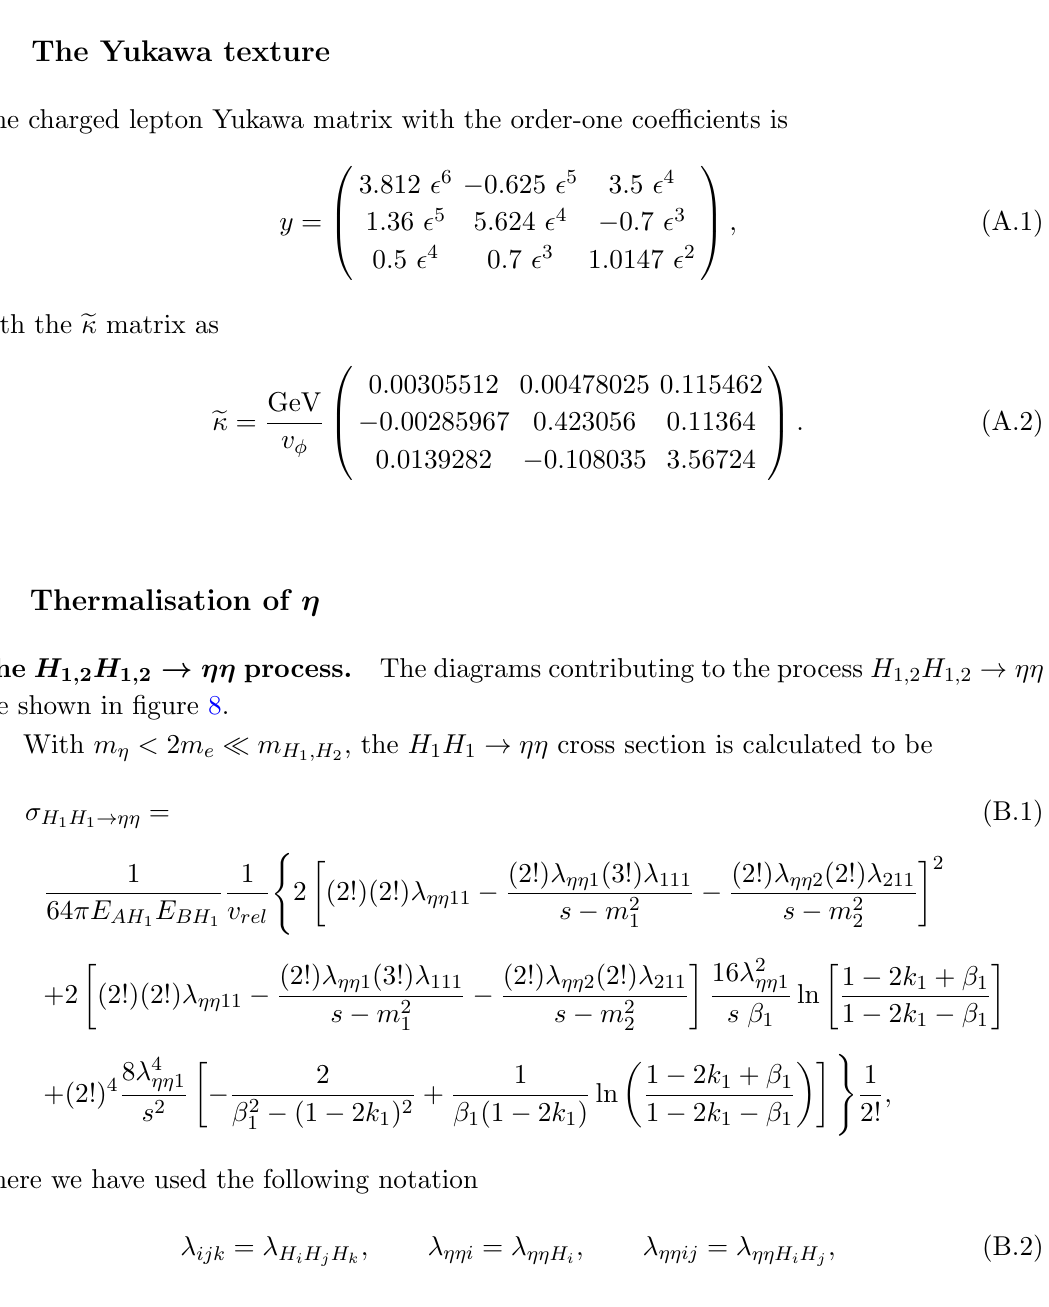
Figure 8 . The diagrams contributing to the H 1 ; 2 H 1 ; 2 ! (cid:17)(cid:17)